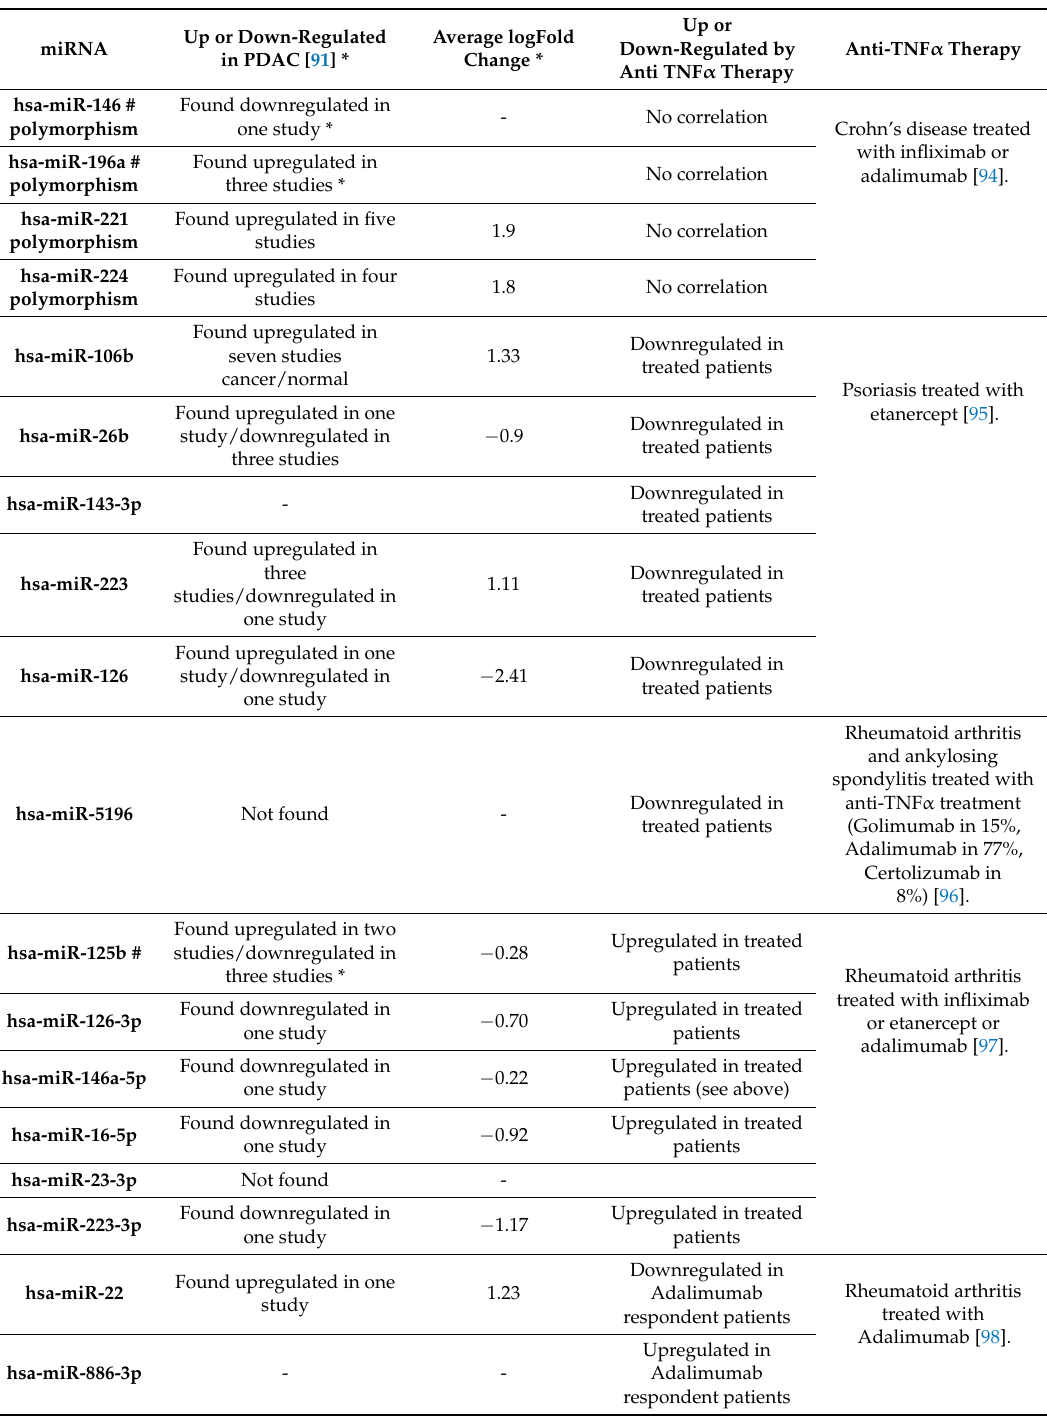
Table 2. Anti-TNF α , miRNA de-regulated expression, and PDAC. To construct the table, studies that evaluated the effects of anti-TNF α therapy on miRNA expression were first selected. Secondly, those on miRNA that reported to be also associated with PDAC were chosen and detailed in the table. Only the RT-PCR-validated or statistically significant miRNA were used for the